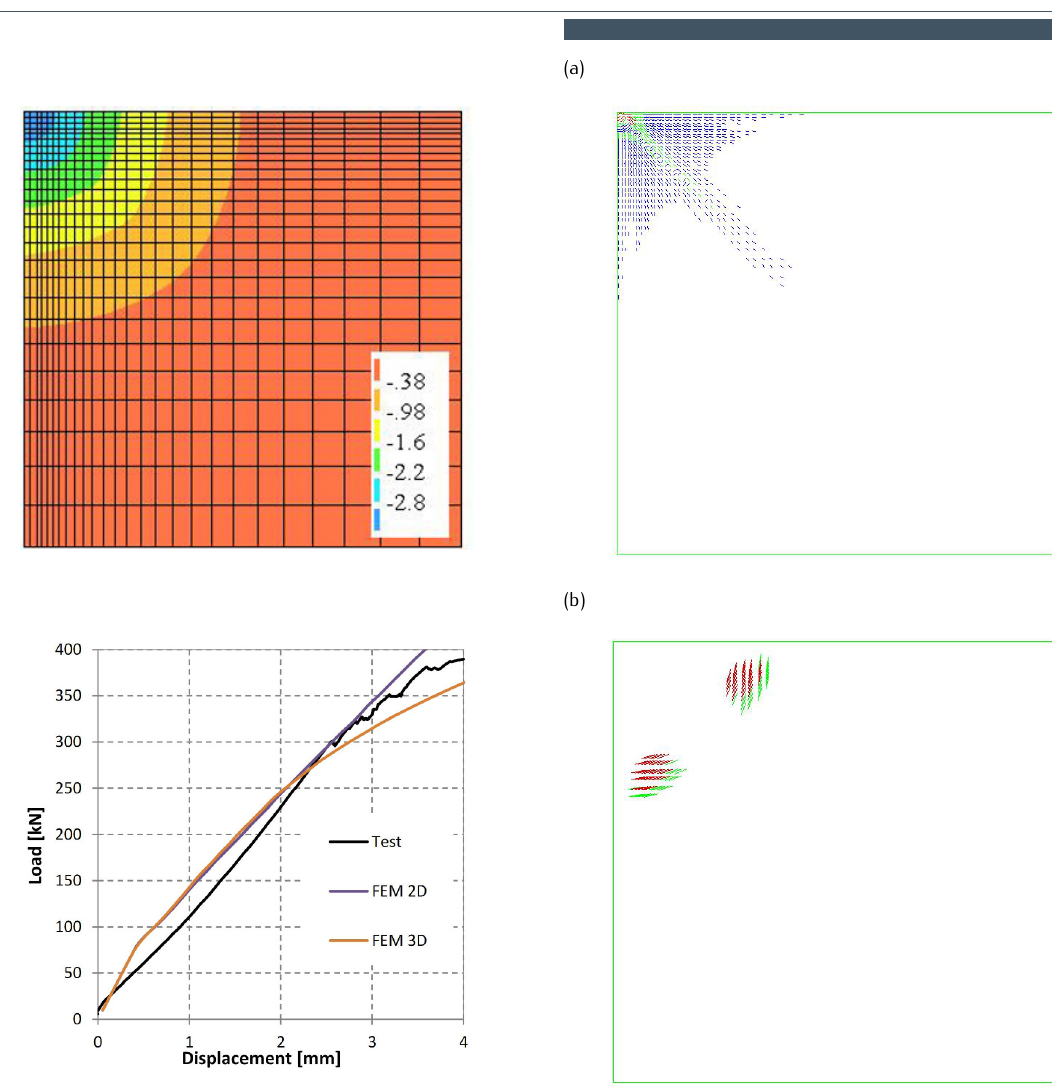
centre towards the edges and the diagonals, as it can be observed in the crack pattern of Figure 16.